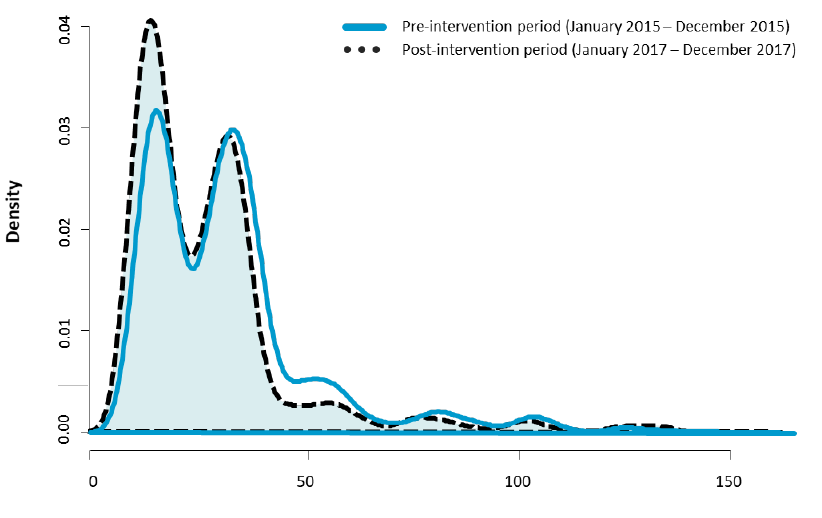
11 of 12 Table A2. Student’s t -test results of the time (hours) required to order TPN by ward physicians for patients with NST referrals during the pre- and post-intervention periods.